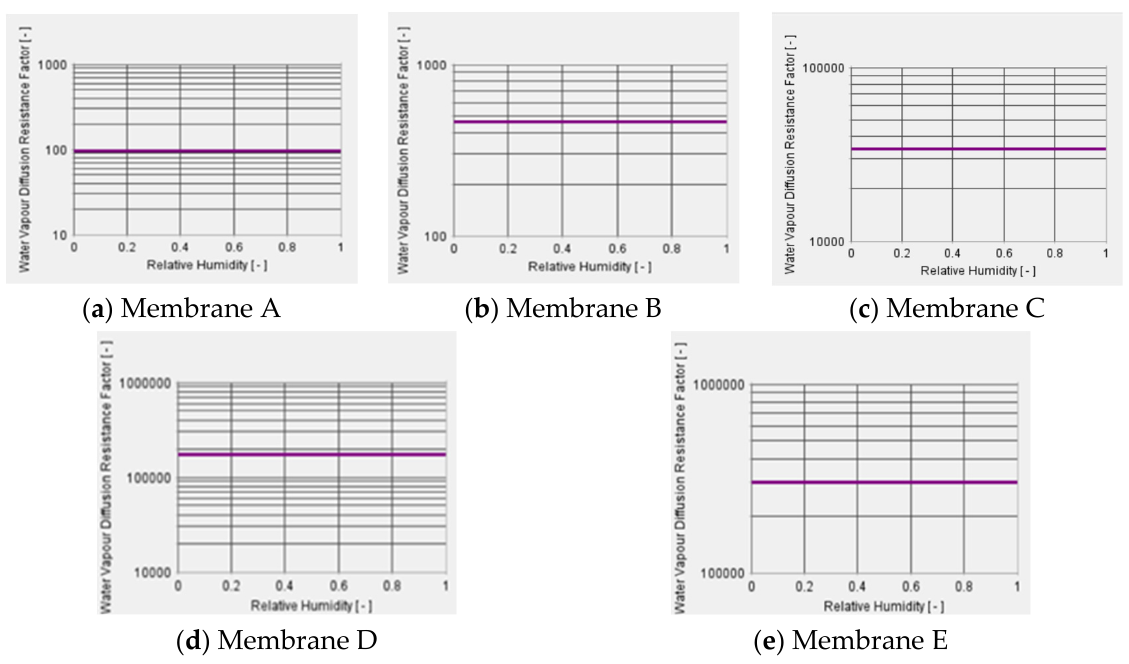
Figure 2. Single-point water vapour diffusion resistance factor graphs for the five tested pliable membranes.